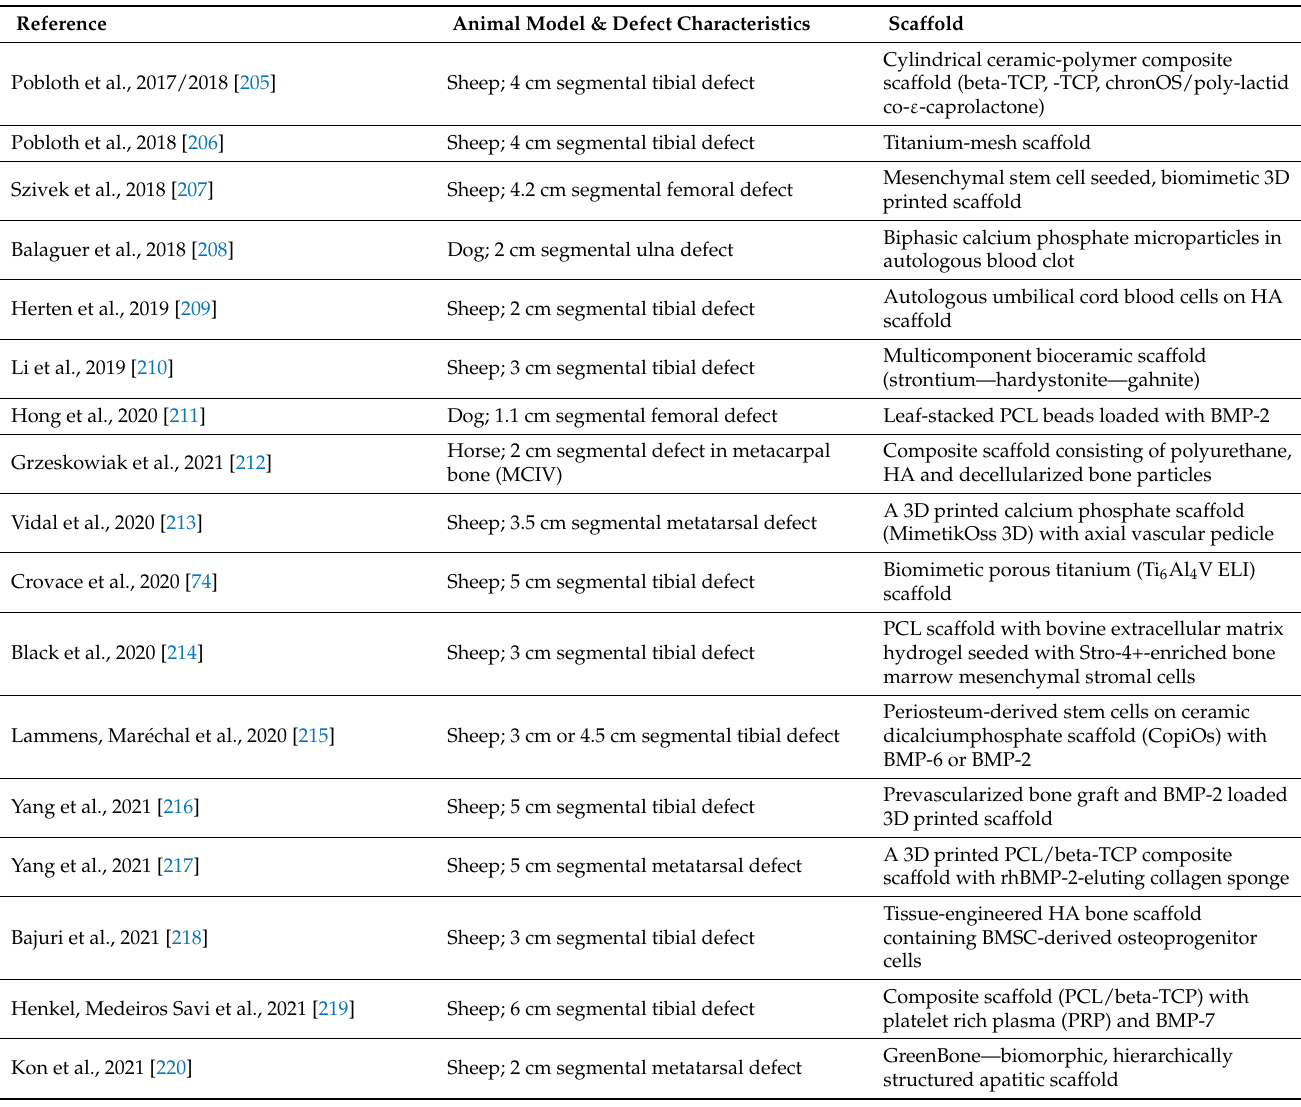
Table 1. Selected studies testing new scaffold-based approaches for full-thickness long-bone defects in large animal models between 2018 and 2022 (exemplary overview; no systematic literature